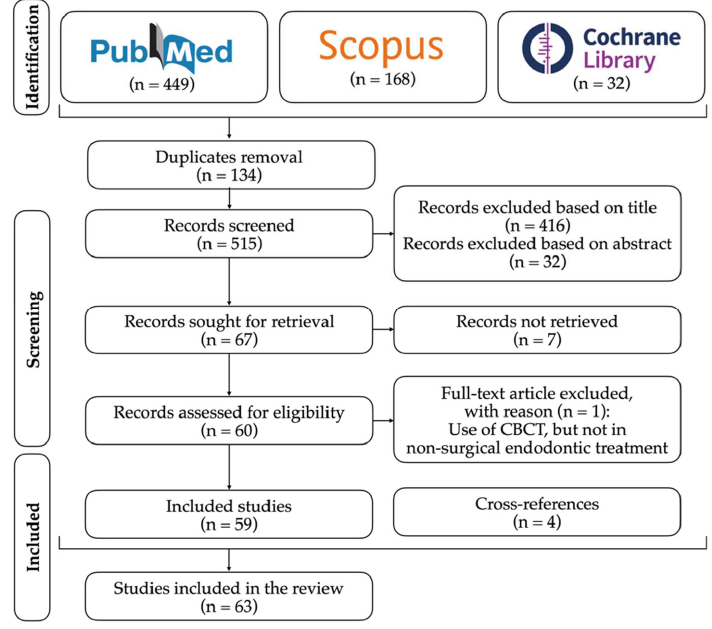
Figure 1. Flowchart of studies selection.